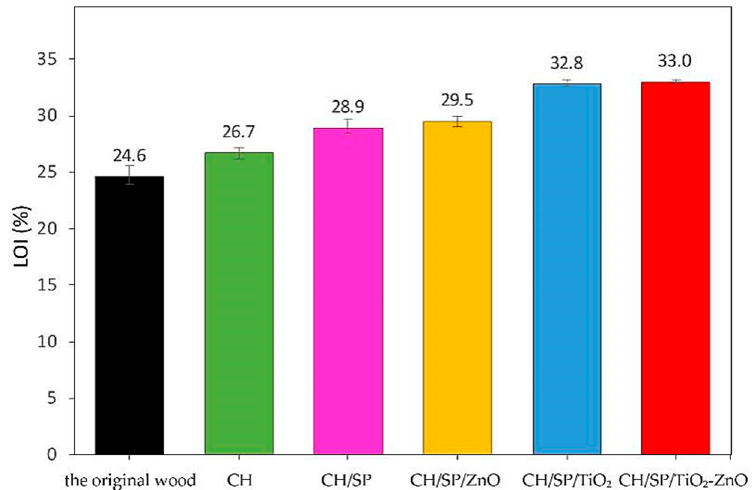
Figure 4. Limiting oxygen index (LOI) of the uncoated wood (black), CH coated (green), CH / SP coated (purple), CH / SP / nano-ZnO coated (yellow), CH / SP / nano-TiO 2 coated (blue), and CH / SP / nano-TiO 2 -ZnO coated (red) samples.